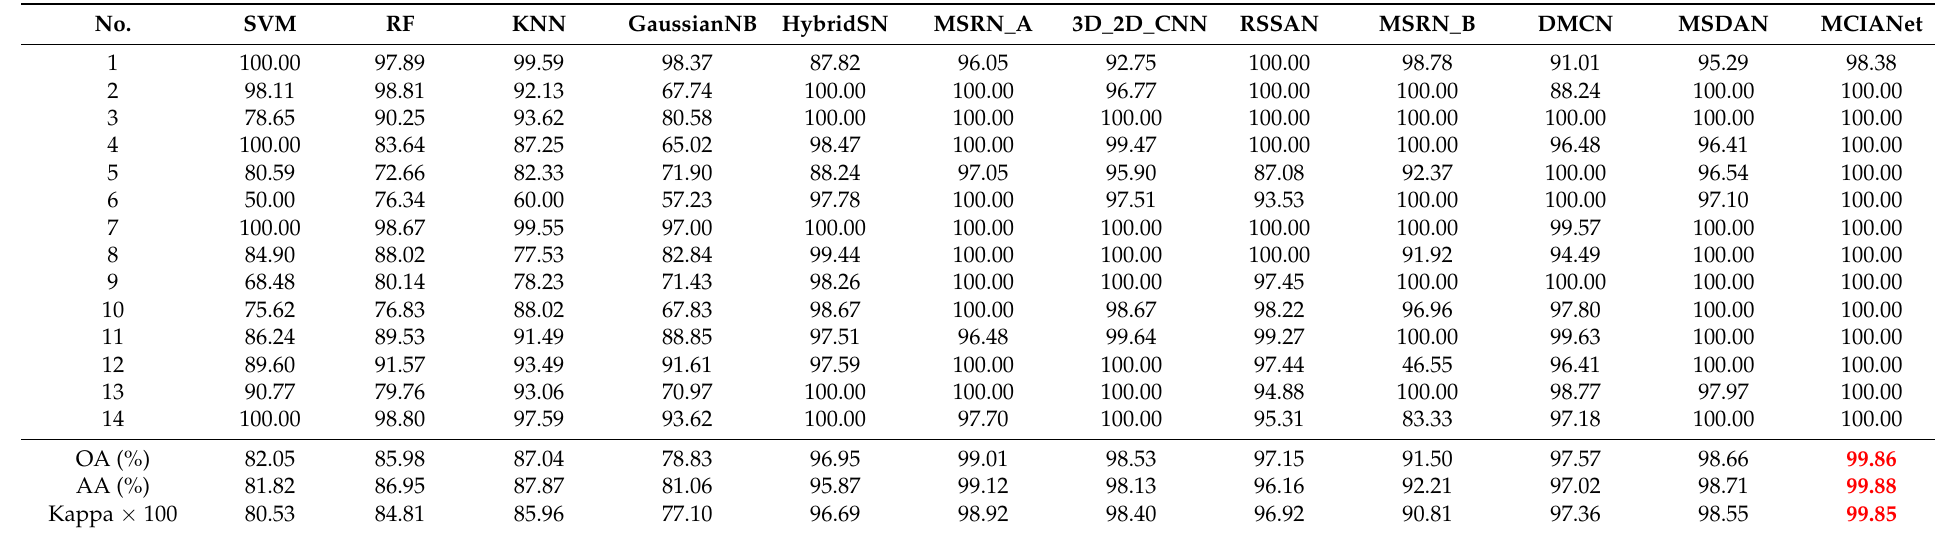
Table 4. The classification results on the BOW dataset.